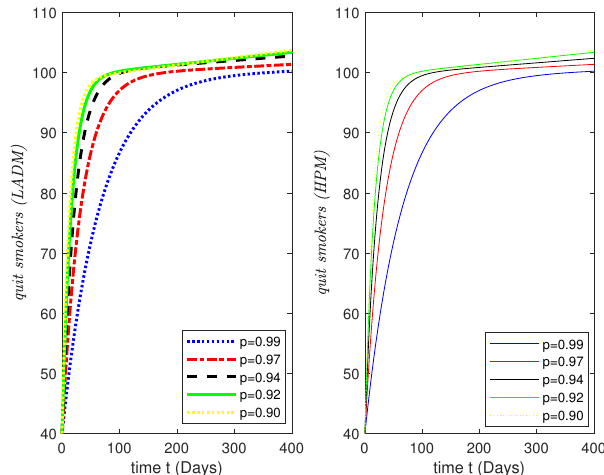
Figure 16. Comparison of the approximate solution for Z ( t ) class of the proposed model having initial condition